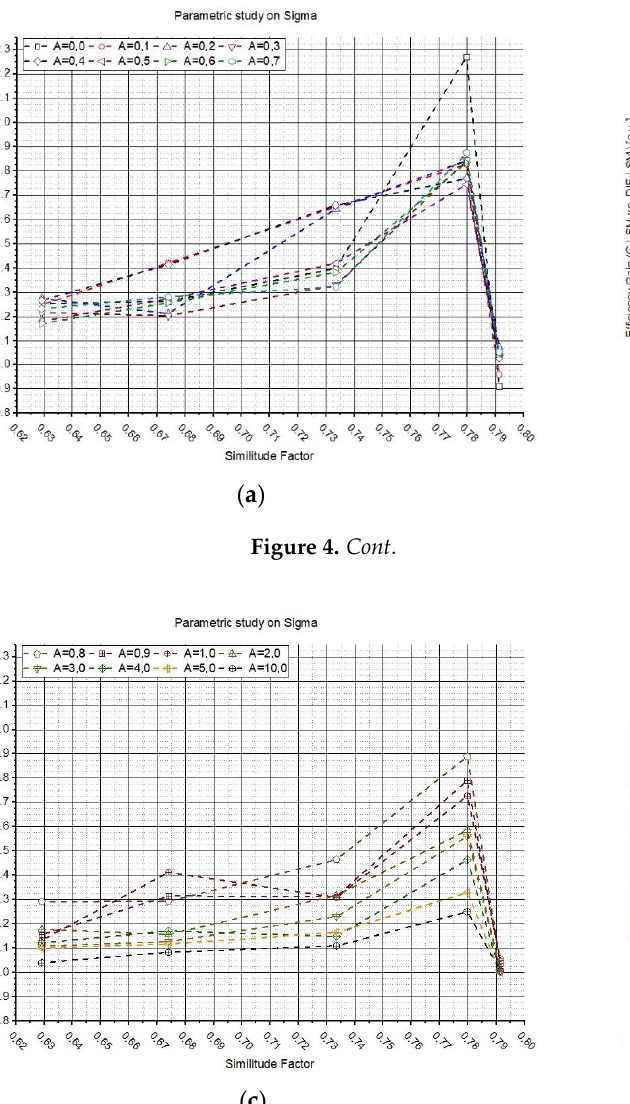
( d ) Figure 3. Influence of the spectrum shapes and A on W DIF -LSM varying σ ( a – c ) and 𝜆 𝑠 ( b – d ) of spectrum 2. Figure 4 shows the results of the two previous studies but plotted as a function of the similitude factor between the two synthetic spectra. In plots (Figure 4a – c), the efficiency